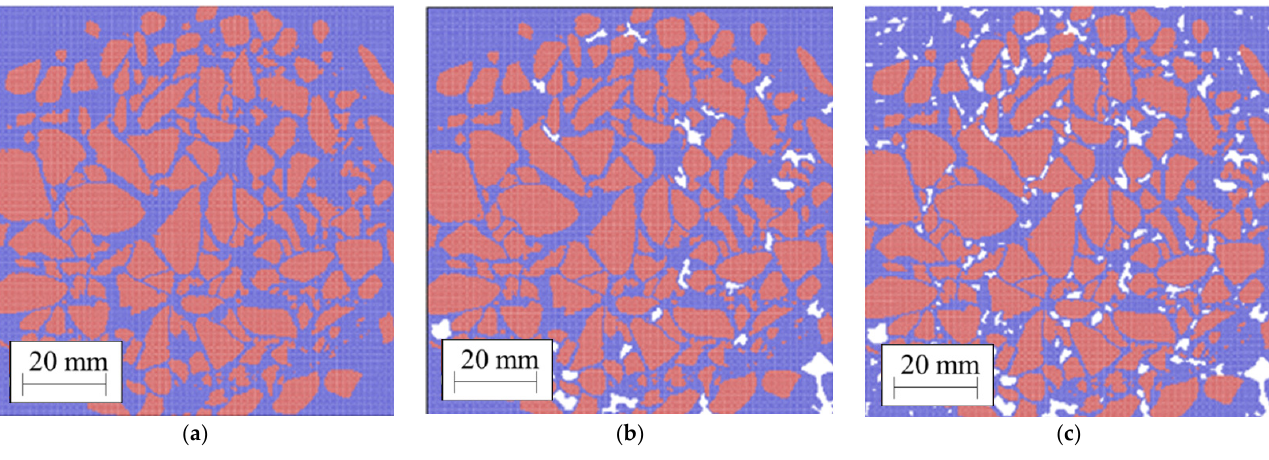
Figure 5. Examples of PA #1 with a range of air void contents. ( a ) 0%; ( b ) 5 %; and ( c ) 10 %. Table 3. Asphalt mixture composition.